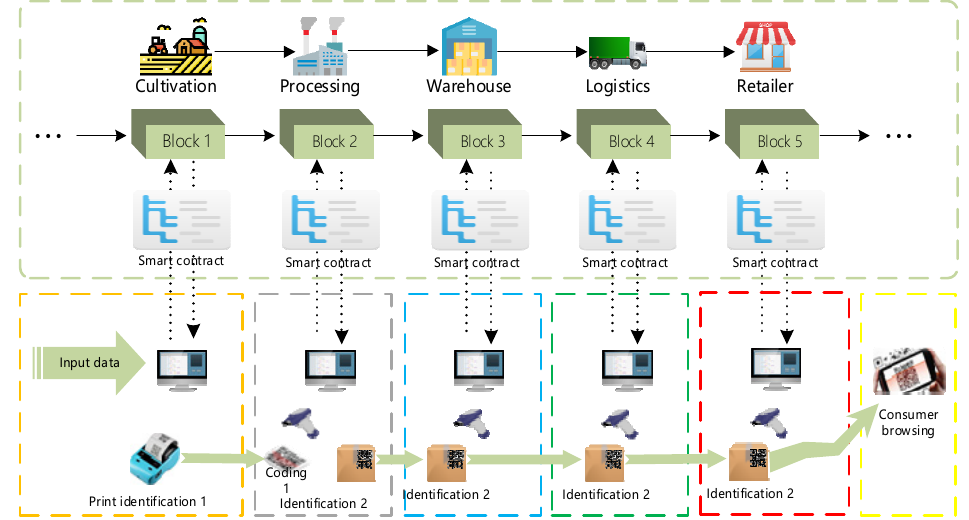
Figure 3. Trusted identity mechanism based on blockchain.